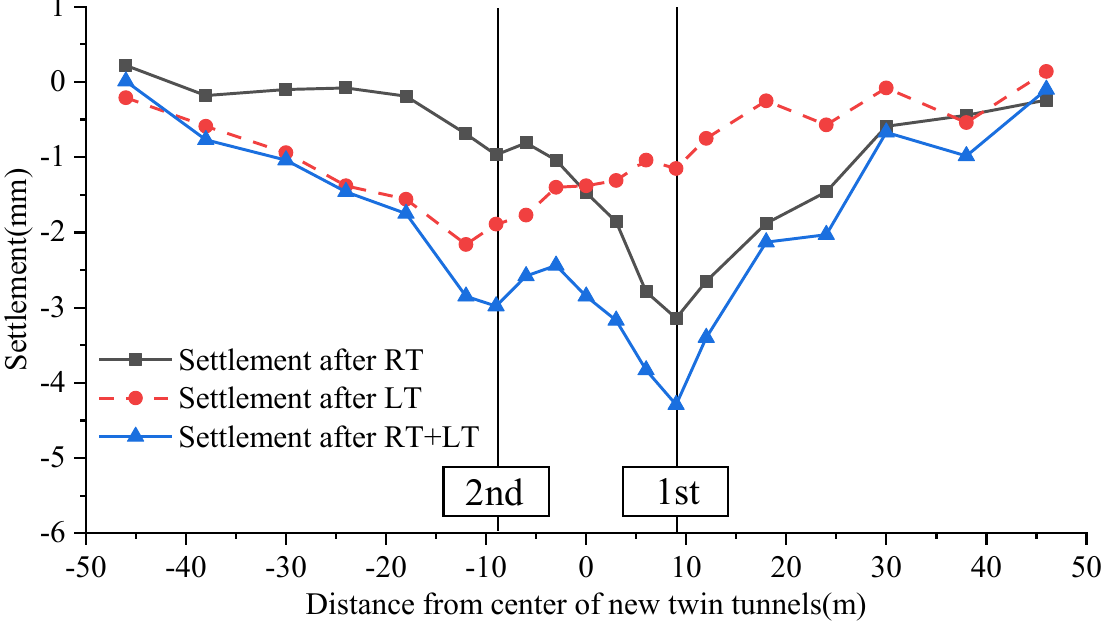
Figure 10. Subsidence profile s of the existing large-diameter shield tunnel.